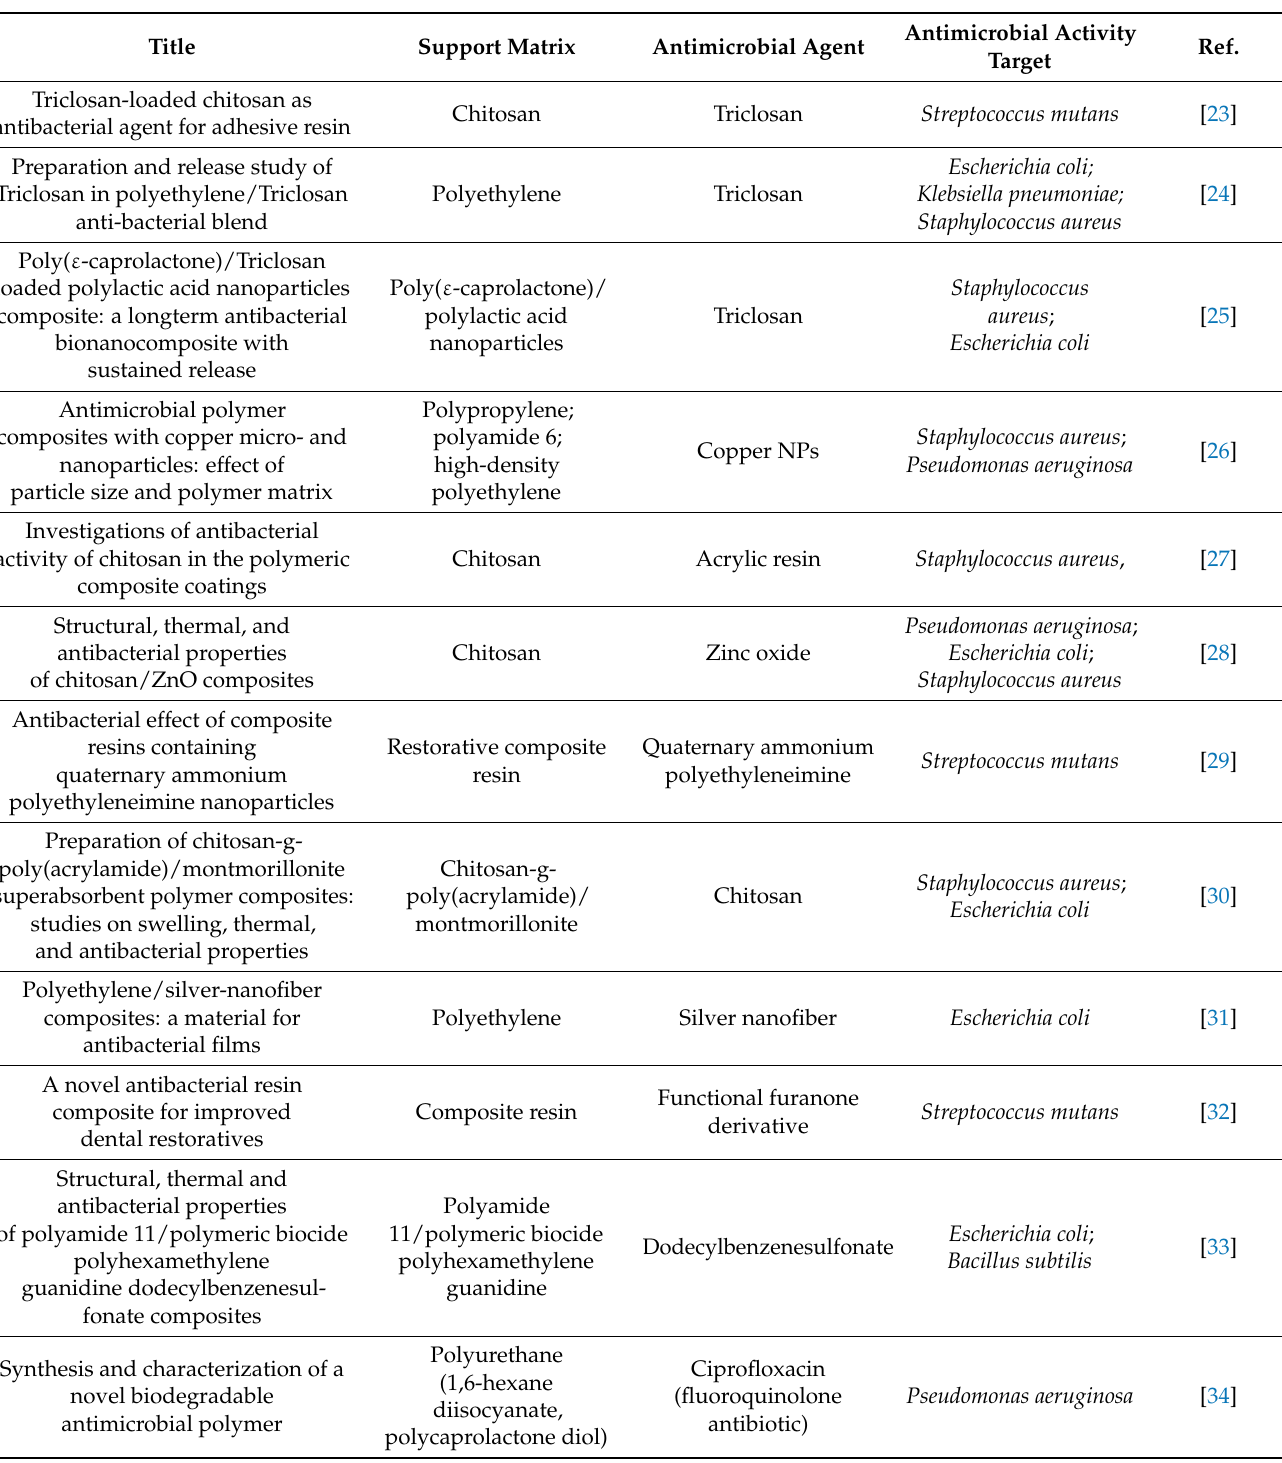
Table 1. Selected research on polymer and composite materials loaded with antimicrobial